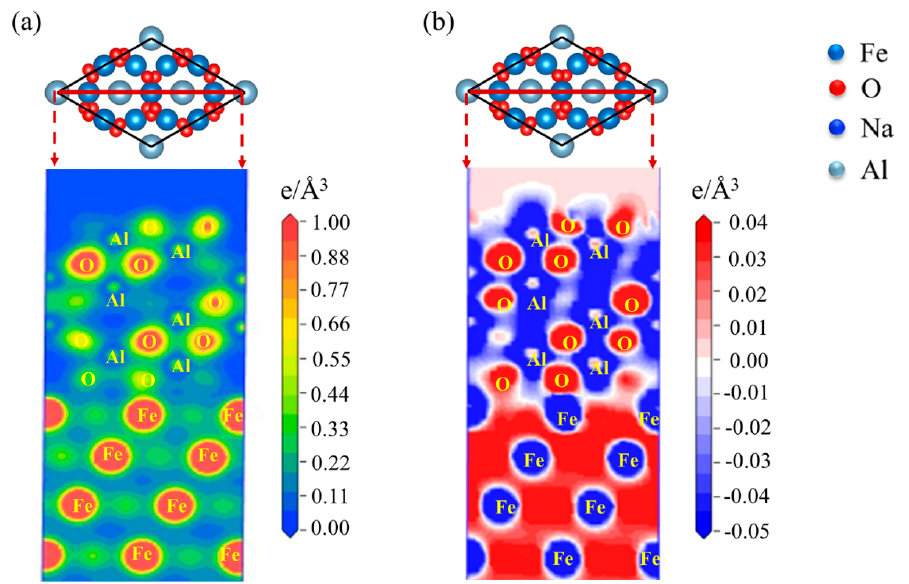
Figure 8. The ( a ) charge density and ( b ) charge density difference of the Fe − Al 2 O 3 interface at (111) crystal plane.